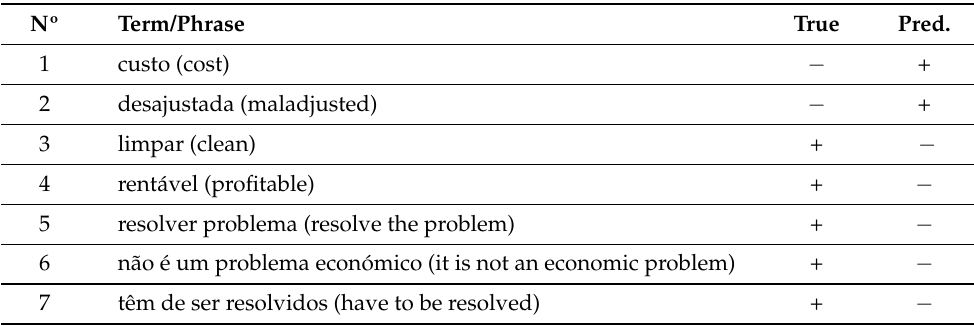
Table 14. Examples of some errors of the deep-learning